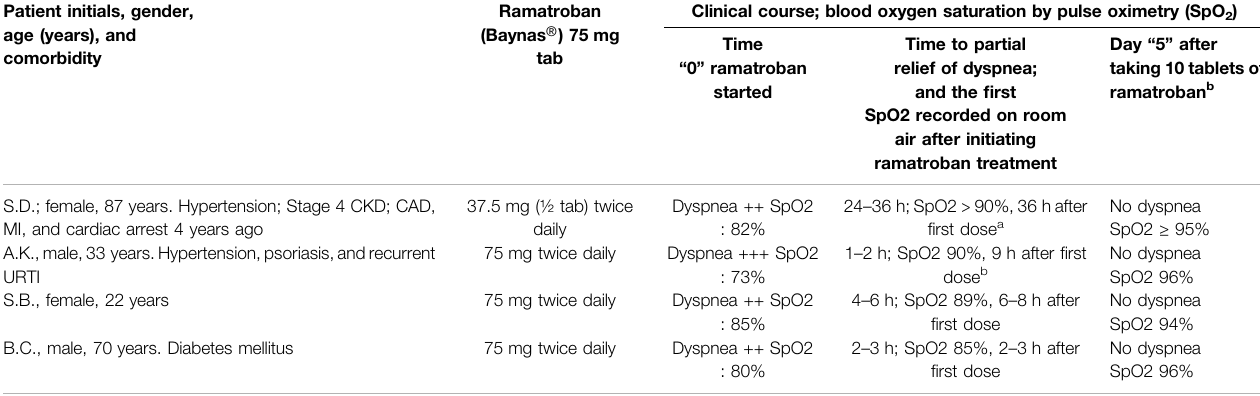
TABLE 2 | Clinical course of COVID-19 patients with acute respiratory distress treated with ramatroban. Patient initials, gender, age (years), and